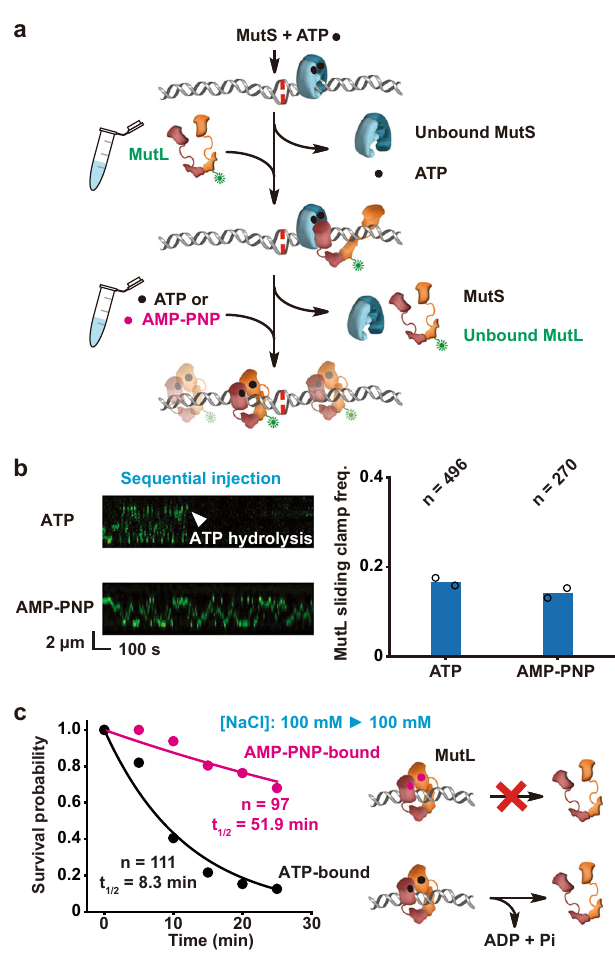
Fig.5|ATPhydrolysisreleasesMutLslidingclampsfromthemismatchedDNA. a An illustration of the two-step injection process that loads ATP-bound MutS sliding clamps and then ATP- or AMP-PNP-bound MutL sliding clamps onto the mismatched DNA. MutS and Cy3-MutL color-coded as described in Fig. 2b. b Representativekymographs(left)andfrequency(right)ofMutLslidingclampson the mismatched DNA examined by two-step injection ( n =total number of DNA moleculesexamined). c Left:SurvivalprobabilityofATP-boundorAMP-PNP-bound MutL sliding clamp. Data were fi t by exponential decay functions to obtain a sur- vival half-life ( t 1/2 , mean±s.e; n =number of events examined); Right: Illustrations showing that MutL color-coded as described in Fig. 2b bound by AMP-PNP (magenta dots, top) is substantially resistant to hydrolysis and ring opening, while ATP (black dots, bottom) hydrolysis opens the MutL ring-like clamp to dissociate the protein from